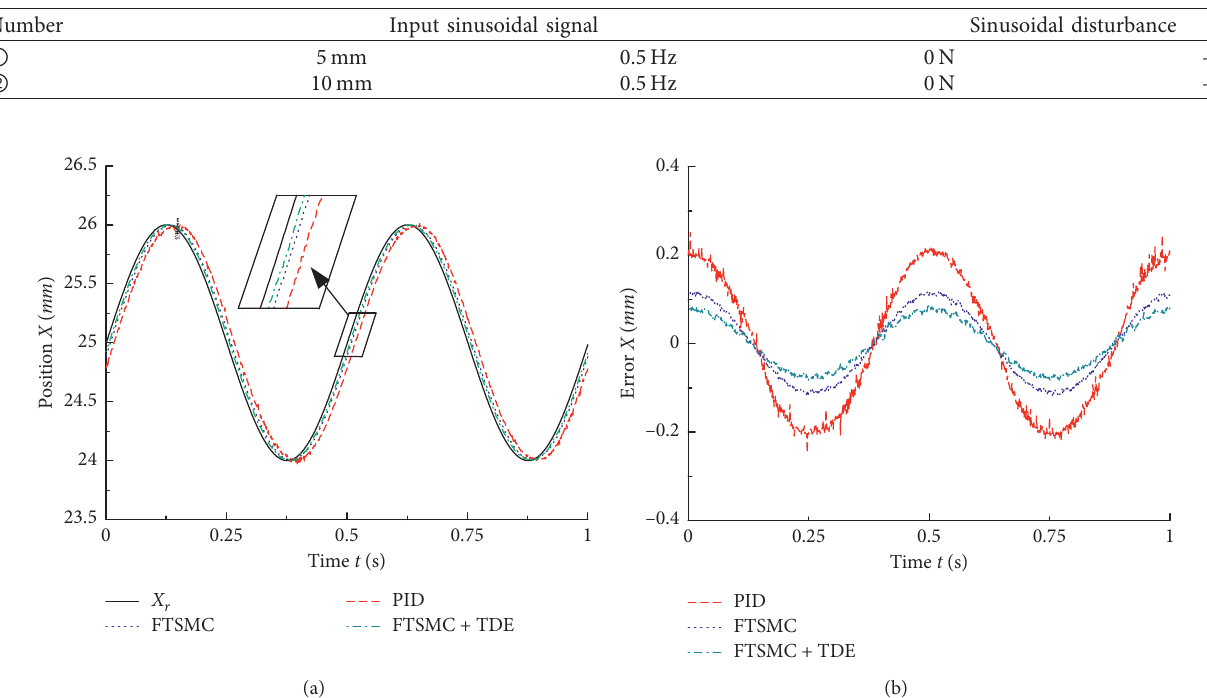
Table 5: Experimental plan of the load simulation experimental